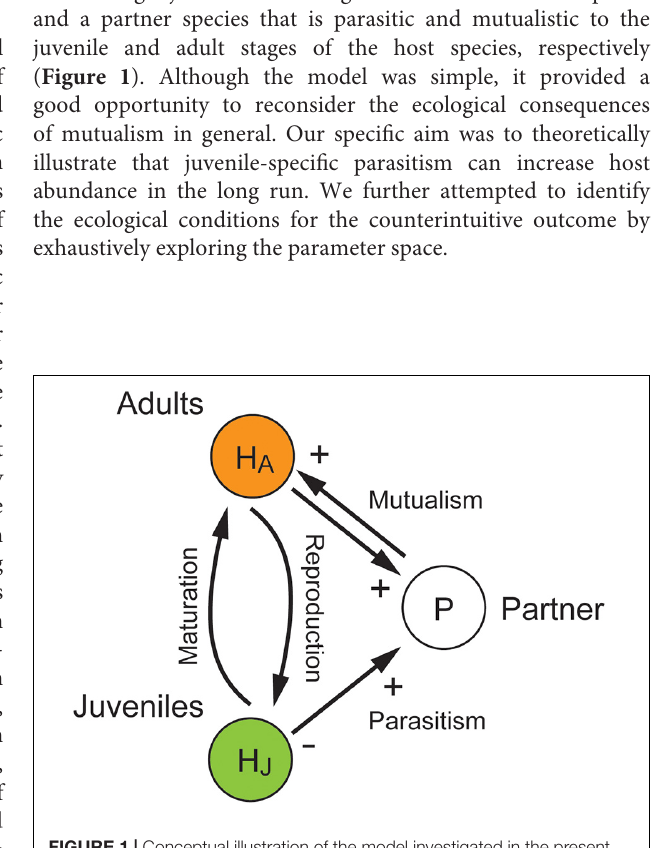
FIGURE 1 | Conceptual illustration of the model investigated in the present study. The host species exhibits a juvenile–adult stage structure and the partner species is parasitic and mutualistic to the juvenile and adult stages of the host species,